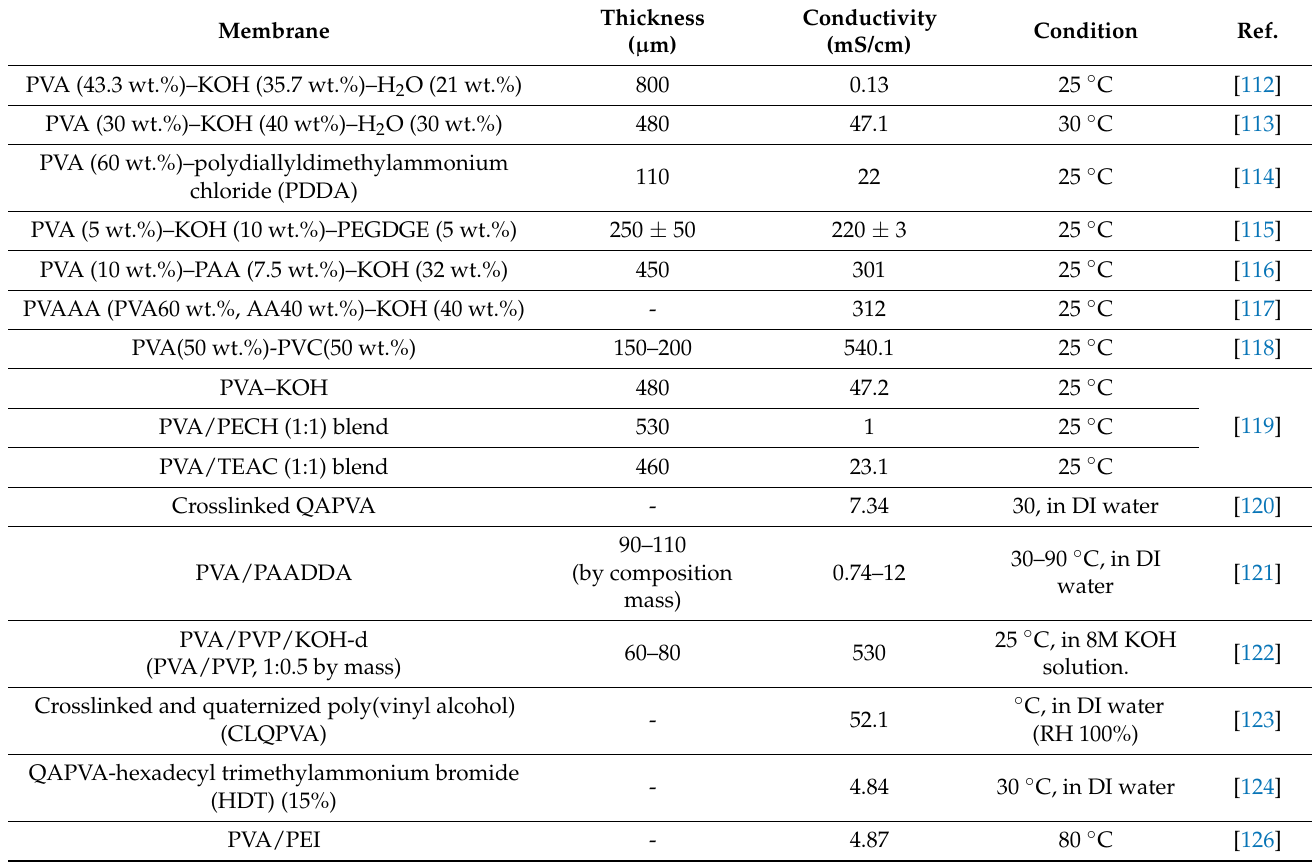
Table 5. Ionic conductivity of PVA-based